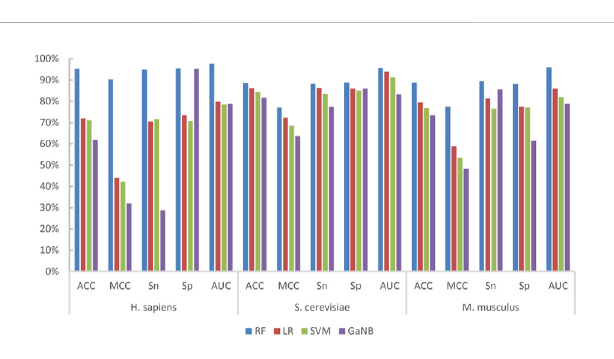
FIGURE 4 The performances of the four base-classi fi ers for H. sapiens , S. cerevisiae , and M. musculus